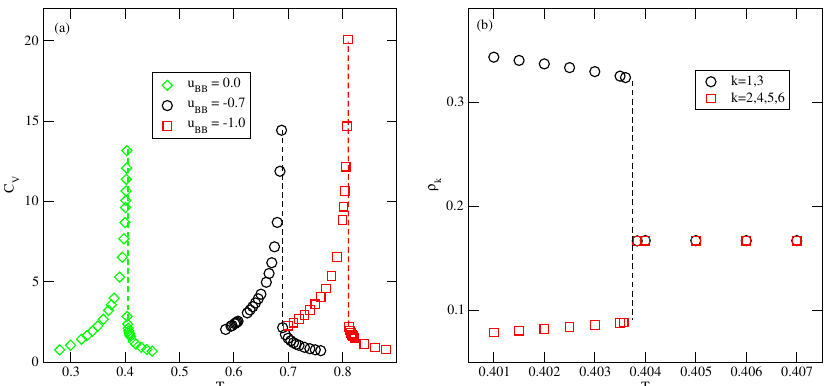
Figure 13. (Part ( a )) The examples of heat capacity curves for the closed packed systems with different u BB , obtained from the canonical ensemble Monte Carlo simulations. (Part ( b )) Temperature changes of the densities ρ k for the system with u BB =